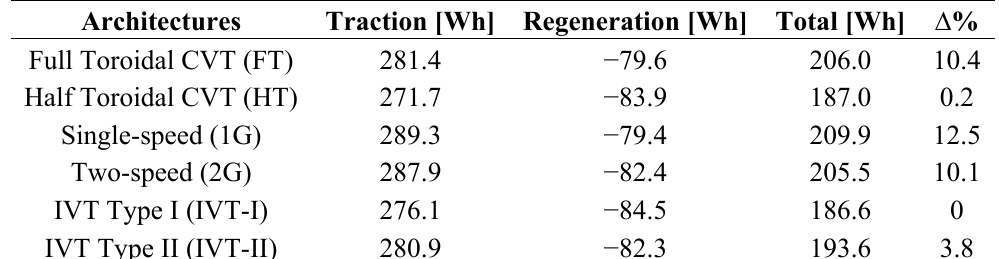
Table 4. Energy consumption in Wh along the UDC.